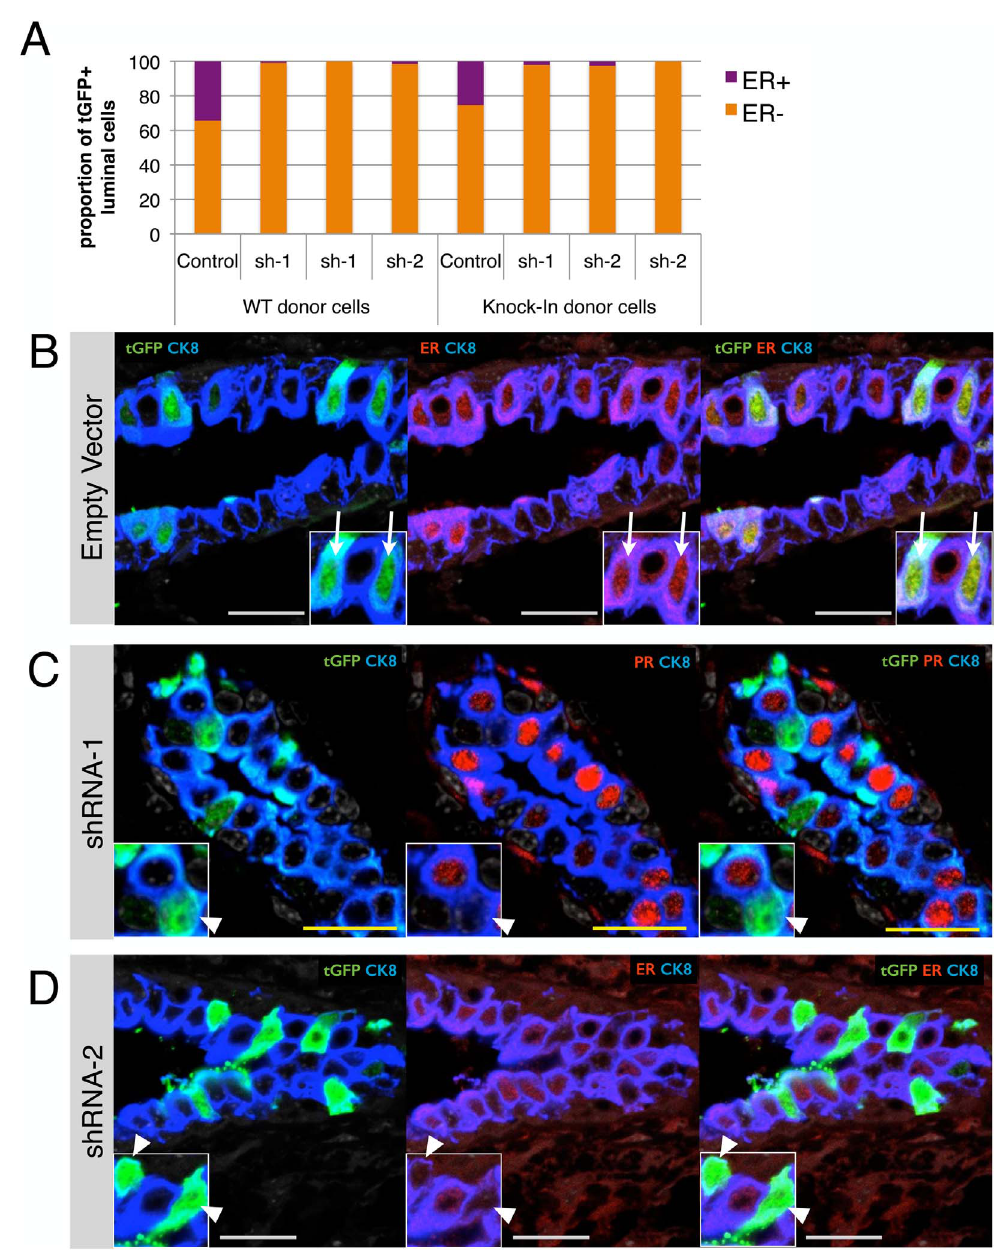
Figure 6. Tbx3 is required for the generation of hormone-sensing cells. (A) Primary MECs from wildtype or KI mice were transduced with a non-silencing lentiviral vector (control) or with two independent short hairpins against Tbx3 (sh-1 and sh-2). Cells were injected into mammary fat pads devoid of endogenous epithelium and outgrowths were analyzed 8–10 weeks later for the identity of lentivirally transduced cells (recognized by tGFP expression). See File S4B for a schematic experimental design. Each bar represents one fat pad and 46 to 569 tGFP + luminal cells were counted per fat pad. There is a significant bias against the formation of HS cells by cells with Tbx3 knockdown (Chi square of shRNA versus control transplant , 0.01). (B) Paraffin section of a cleared mammary fat pad transplanted with MECs that were exposed to the non-silencing control vector. Transduced cells are identified with an antibody staining against tGFP (green), luminal cells are identified by cytokeratin 8 (blue) and HS cells are identified by the estrogen receptor (ER, red). White arrow indicates transduced cells contributing to the hormone-sensing lineage. (C) Paraffin section of a mammary fat pad transplanted with MECs exposed to the first short hairpin against Tbx3. White arrow head indicated transduced cells in the luminal alveolar (ER-negative) lineage. The background of immunohistochemistry is higher in transplanted samples (arguably due to fibrosis). Where ER staining was ambiguous due to high background, we used progesterone receptor (PR, red) staining as an alternative marker for HS cells. (D) Paraffin section of a mammary fat pad transplanted with MECs exposed to the second short hairpin against Tbx3. White arrow head indicates transduced cells in the luminal alveolar (ER-negative) lineage. White scale bar is 20 m m and yellow scale bar is 10 m m.